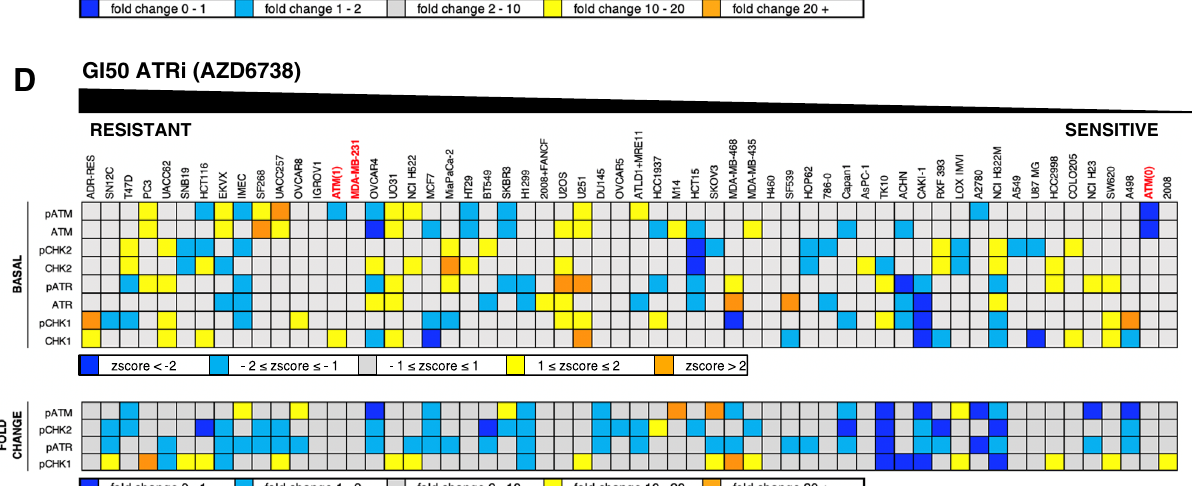
Figure 4. Relationship between sensitivity to MK-8776 or AZD6738 and endogenous DNA damage or DDR pathway function. ( A ) A representative western blot in which the internal standard cell line (AsPC-1) and additional cell lines (HT29, COLO205, MiaPaca2) were untreated or incubated with 10 ng/mL SN38 for 6 h. Cells were then rinsed with PBS, lysed and analyzed using the indicated primary antibodies and fluorescent secondary antibodies. The full set of western blots is shown in Supplementary Fig. 2. ( B ) Raw signal intensities of the indicated proteins were collected for each ASPC-1 internal standard replicate using Image Studio Lite, then used to calculate SN38- induced fold change. Replicate fold-change values for each protein were then analyzed in GraphPad Prism 8 to generate box-and-whisker plots. ( C ) Raw signal intensities of the indicated proteins were collected for all cell lines using Image Studio Lite, then normalized to the appropriate AsPC-1 internal standard. For basal protein expression (upper panel), AsPC-1-normalized values for each untreated sample were log-transformed and then used to calculate z-scores representing expression of each protein across all cell lines. For fold change (lower panel), AsPC-1-normalized values for untreated and SN38-treated samples for each cell line were used to calculate the fold change of each protein. Cell lines were sorted by MK-8776 GI50 (Fig. 1A). ( D ) The data in panel C is resorted by GI50 for AZD6738 (Fig.